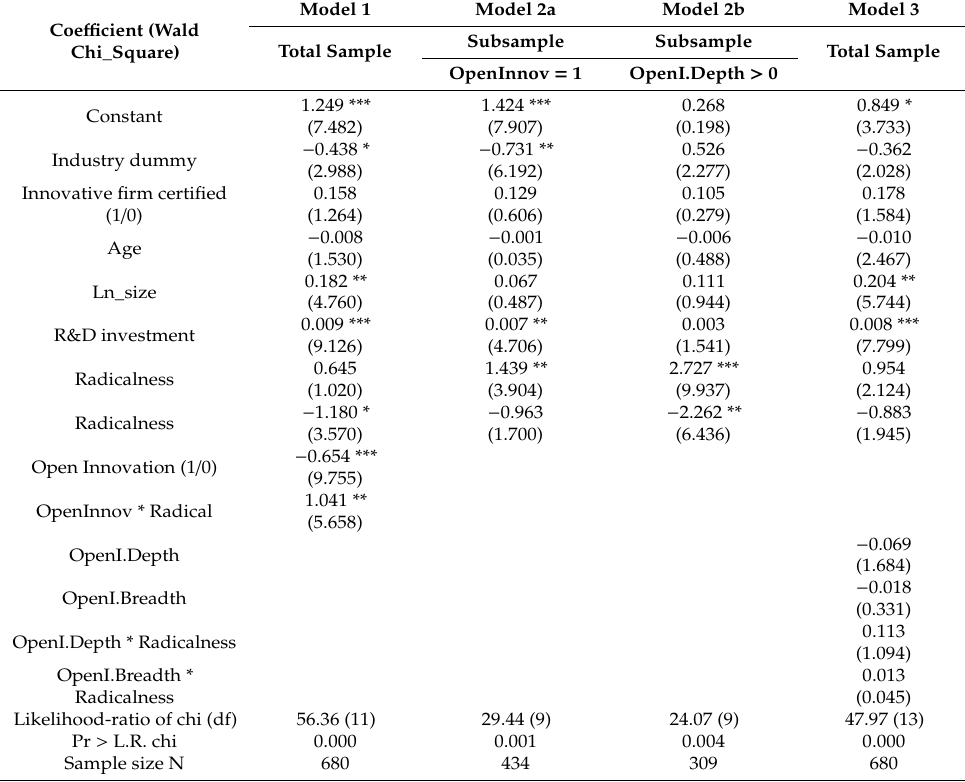
Figure 1. Inverted-U curve of patent application performance: open vs. non-open innovation firms: ( a ) Log (Patent Application)-Radicalness; and, ( b ) simplified with fitting curve. Negative binomial regression on the number of patent applications–inbound open innovation